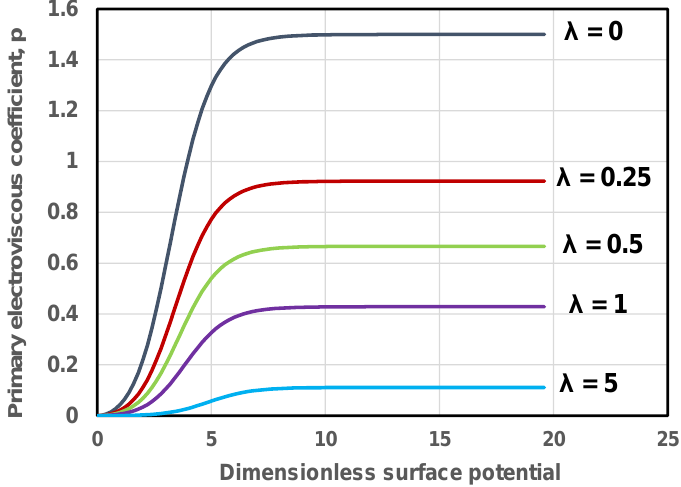
~  for different values of viscosity ratio  . Figure 21. Primary electroviscous coefficient p versus (cid:101) ψ 0 for different values of viscosity ratio λ